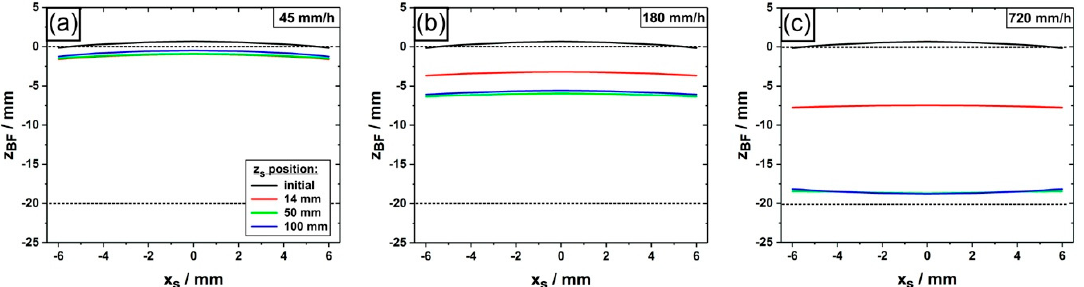
Figure 13. Effect of withdrawal rates on the evolution of liquidus isotherm curvatures and positions during Bridgman processing. Different casting stages (early, intermediate and late) correspond to different z S -values in the bar (low: 14 mm; intermediate: 50 mm; high: 100 mm). ( a ) v = 45 mm/h, ( b ) v = 180 mm/h ( c ) v = 720 mm/h. For details see text. Figure 12. Correlation between dendrite growth directions and crystal orientations. ( a ) SEM back scatter electron (BSE) micrograph. ( b ) Corresponding RVB-EBSD map of the [001] direction; for color-